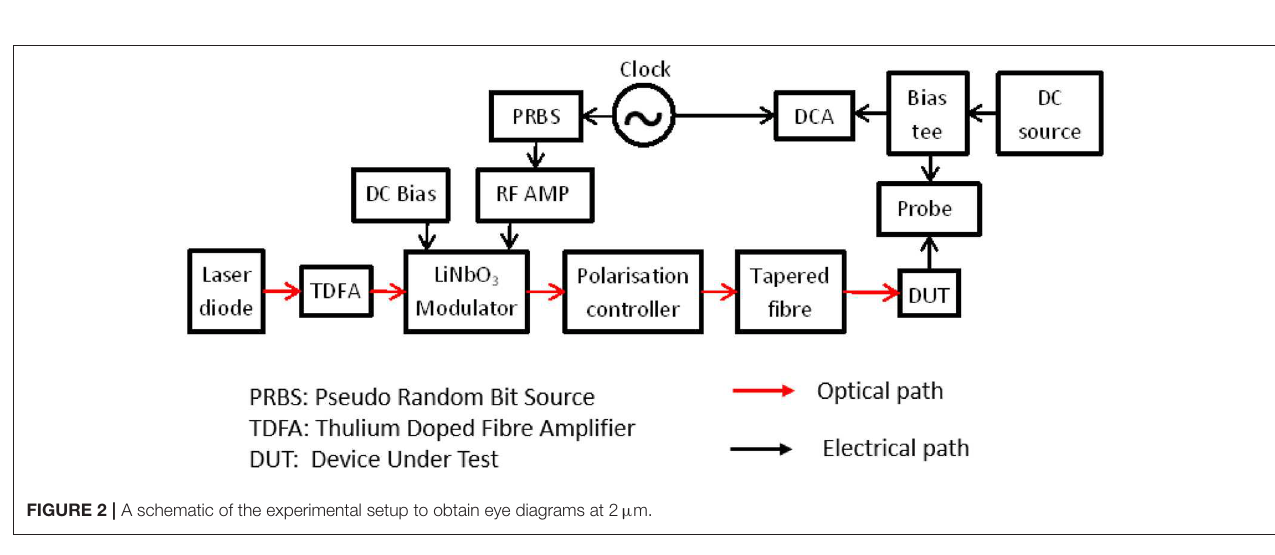
FIGURE 1 | (a) The top-view SEM image of the typical device (Inset) its cross-sectional view. (b) Cross-section SEM image.